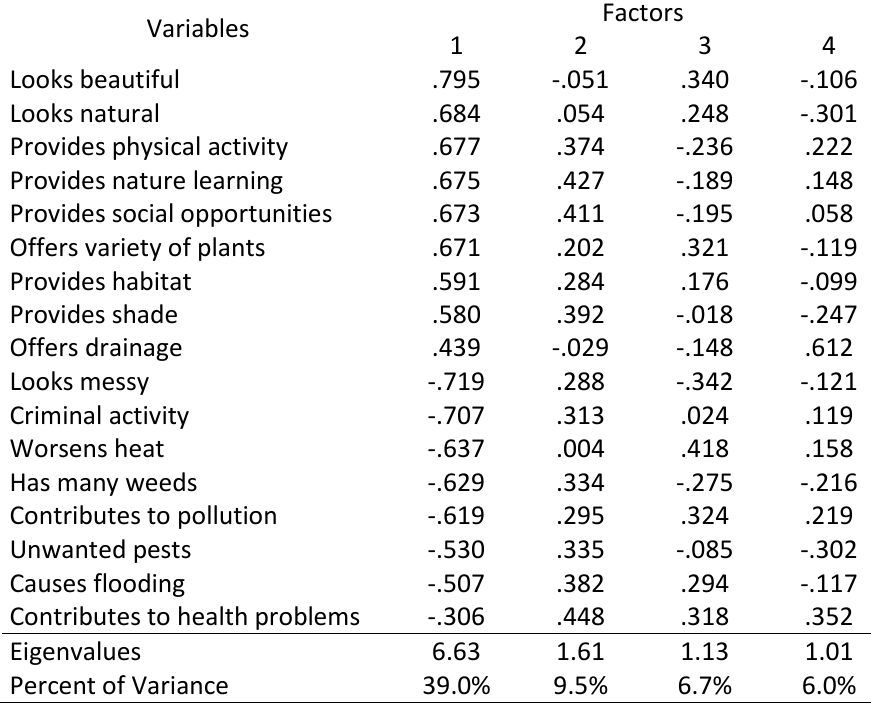
Appendix B. Components Matrix from Factor Analysis for All ES & EDS Variables. Eigenvalues and the amount of variance explained are presented below the factor loadings bottom. The rotation failed to produce a pattern matrix in twenty-five